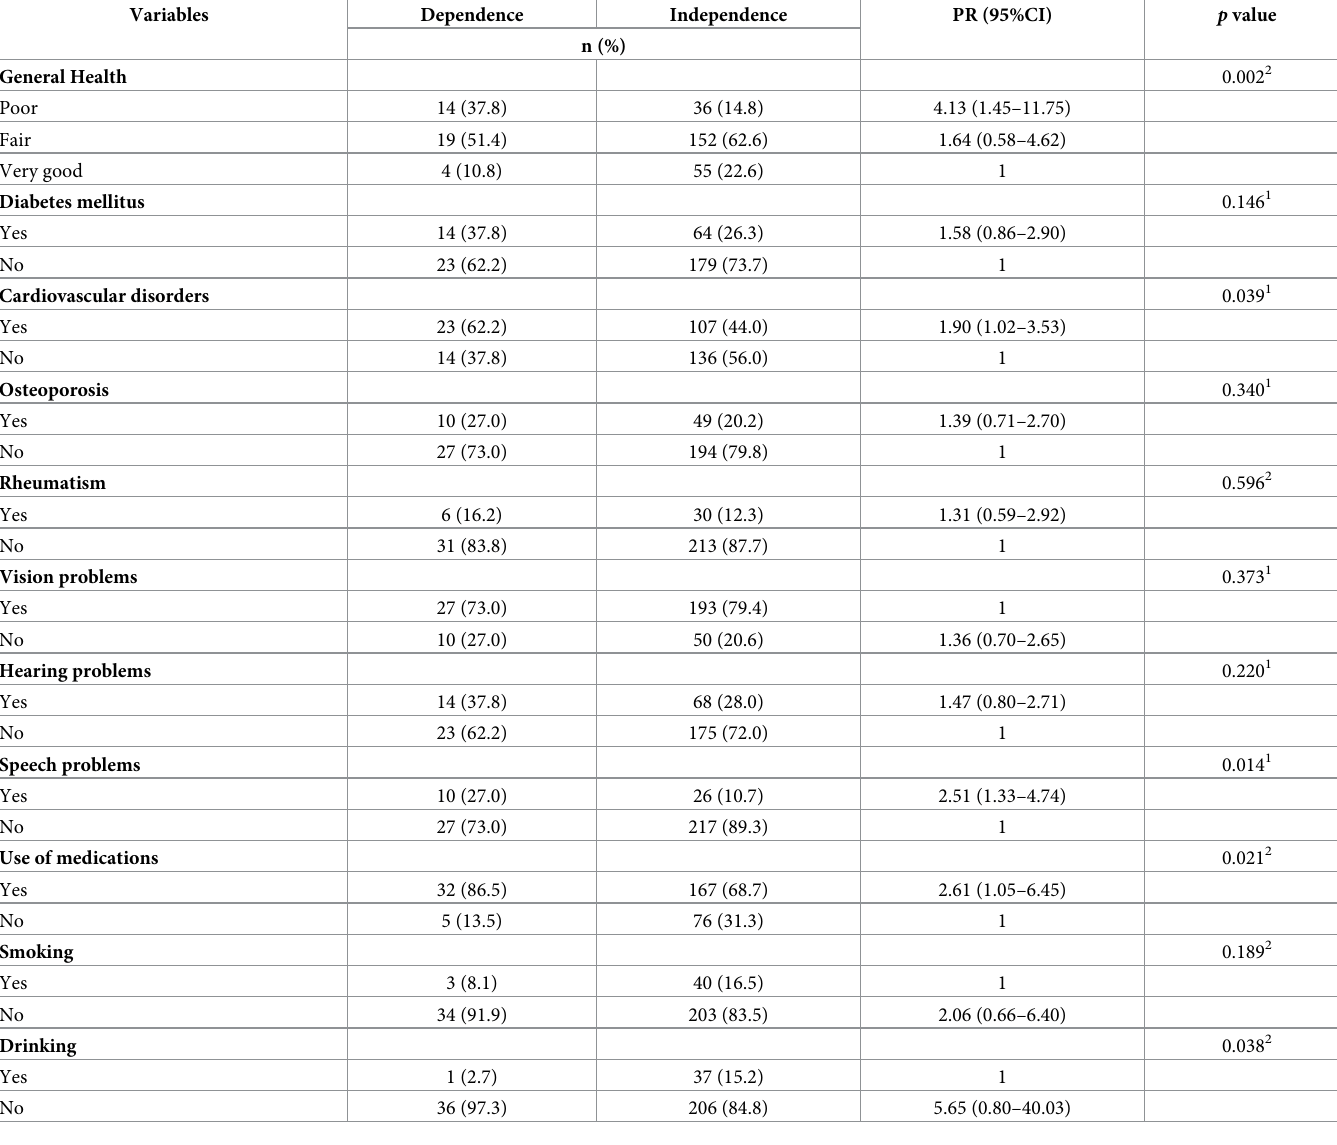
Table 2. Frequency distribution and inferential analysis of older people’s general health versus dependence and independence in instrumental activities of daily liv- ing (IADL).